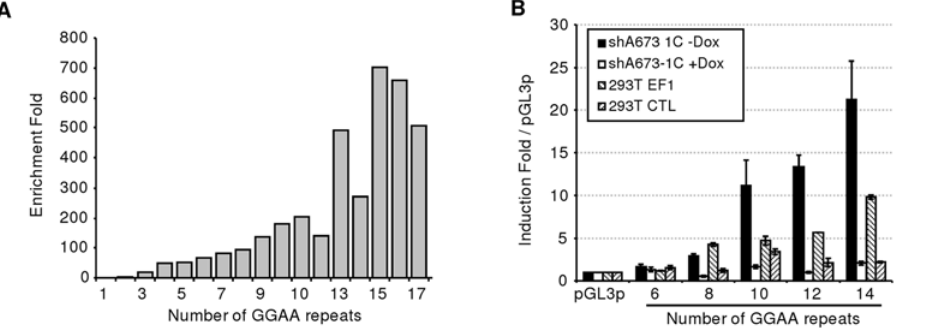
Figure 2. EWS-FLI1 microsatellite length preferences. A. Ratio of the number of GGAA repeats in EWS-FLI1-bound regions to the number of repeat in 50000 randomly picked regions. B. Ability of EWS-FLI1 to modulate transcription of a reporter gene depending upon the number of GGAA repeats. Firefly relative to Renilla luciferase activity is shown. Control experiments with the empty pGL3-promoter vector were set to 1. doi:10.1371/journal.pone.0004932.g002 PLoS ONE |